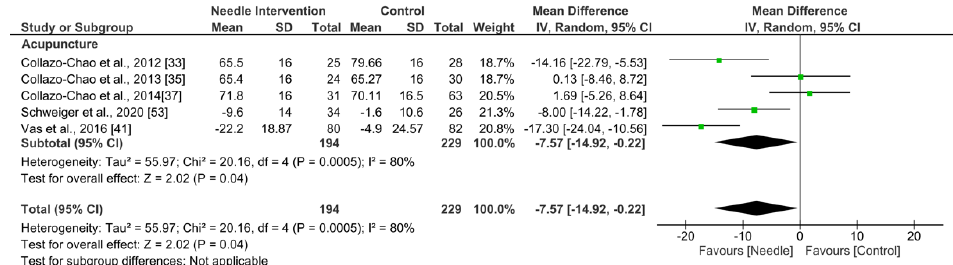
Figure 6. Forest plot for FIQ: 3 – 6 months.